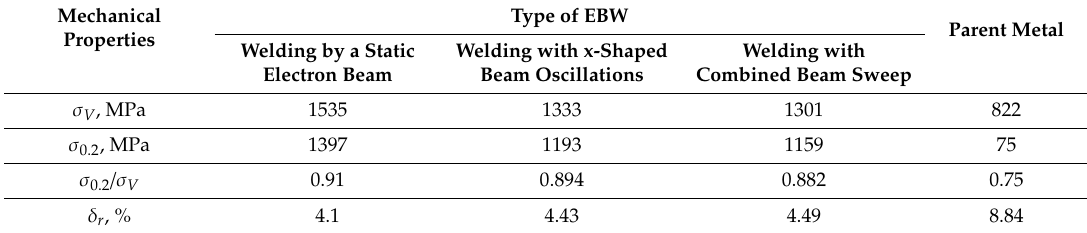
Table 5. Mechanical properties of welded joints produced with di ff erent types of